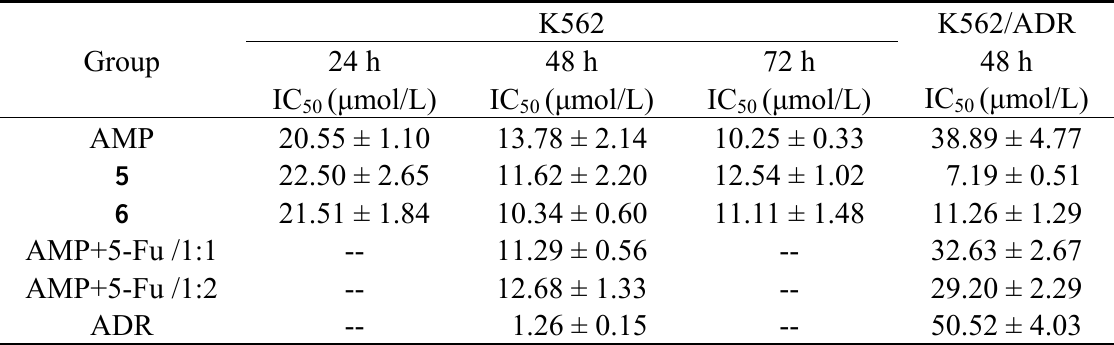
Table 1. The inhibitory effects of 5 and 6 on K562 and K562/ADR cells.